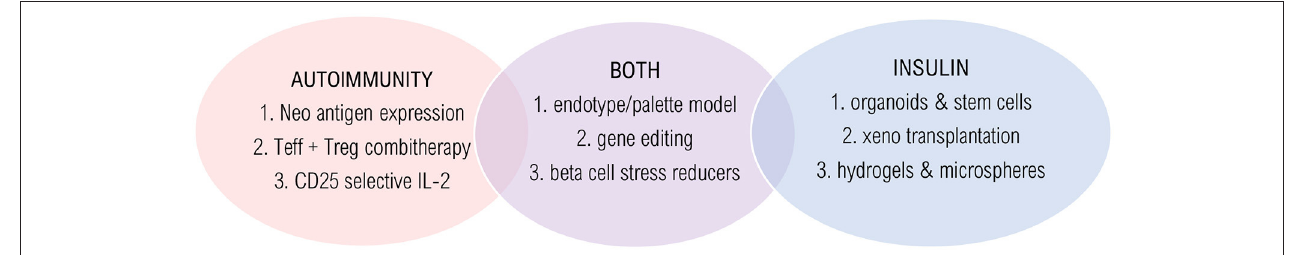
FIGURE 2 | Innovative technologies and solutions. Promising strategies are shown that target autoimmunity (red), insulin deficiency (blue) or both (purple). Autoimmunity solutions: (1) Long-term and low-level antigen expression by AAV infection; (2) Combination therapy of effector T cell depletion followed by regulatory T cell stimulation; (3) Selective CD25-agonist/CD-122 antagonist. Insulin solutions: (1) Glucose sensing beta-cell like organoids that secrete sustained insulin by ex vivo WNT and IFN- γ signaling; (2) Humanized pancreas growth by patient-derived stem cell injection into pig blastocyst; (3) Hydrogels and TMTD-alginate microspheres to avoid rejection and necrosis. Solutions for both: (1) Trial stratification and treatment choice based on endotype; (2) Engineering hypoimmunogenic beta cells using CRISPR-Cas9; (3) Beta cell stress reducers to lower inflammation and increase beta cell